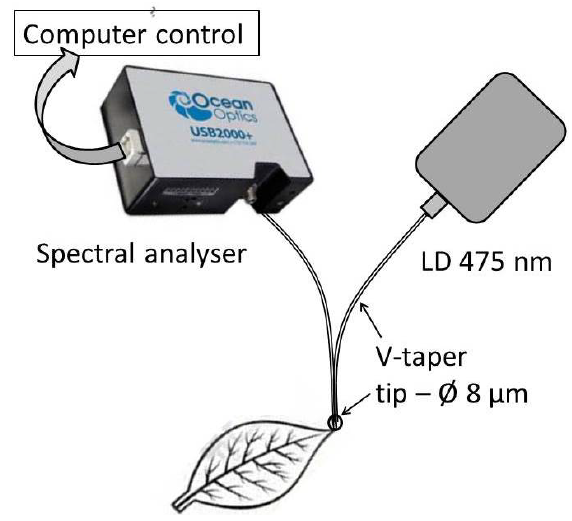
Figure 6. Schema of the laboratory setup of pH measurement by employing a V-taper.